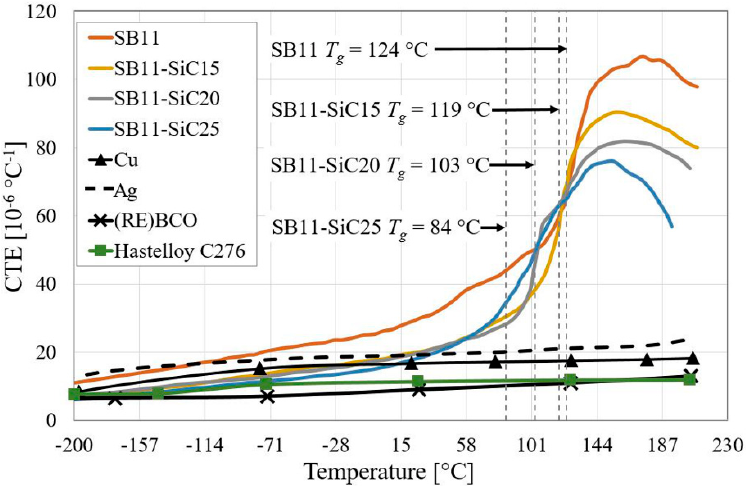
Figure 2. Temperature dependencies of CTE in all investigated composite systems. For comparison, the related data for Cu, Ag, Hastelloy C276 and (RE)BCO are plotted.